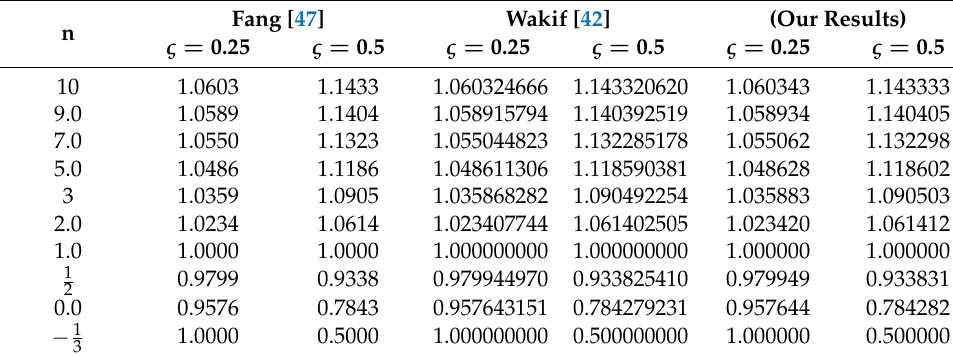
Table 2. Comparison of the Nusselt number Nu x Re − 1/2 x , when n = 1, for different values of Pr and all others parameter are zero.